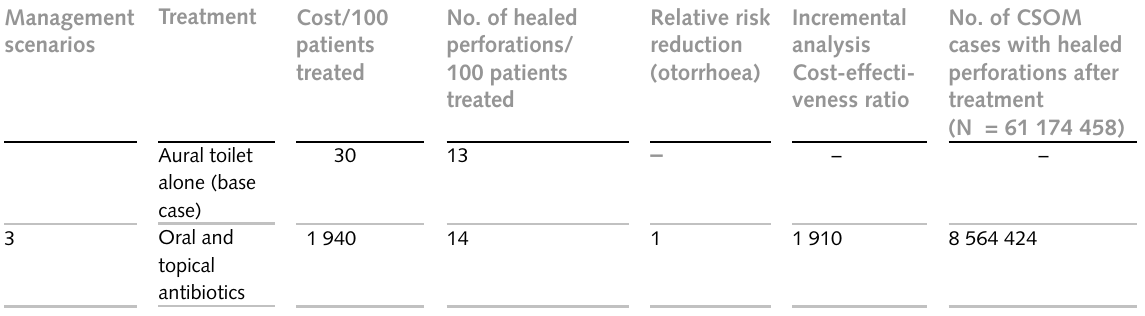
Table 18. Cost-effectiveness analysis of alternative treatments to ear wicking, in terms of resto- ration of